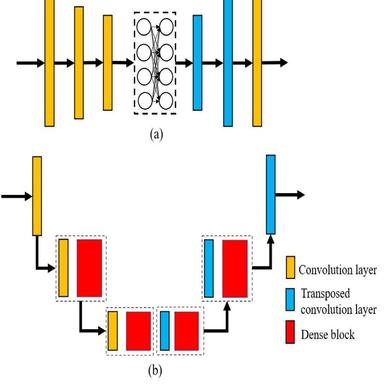
Architectures of (a) RVE-net and (b) DenseED used for investigation.